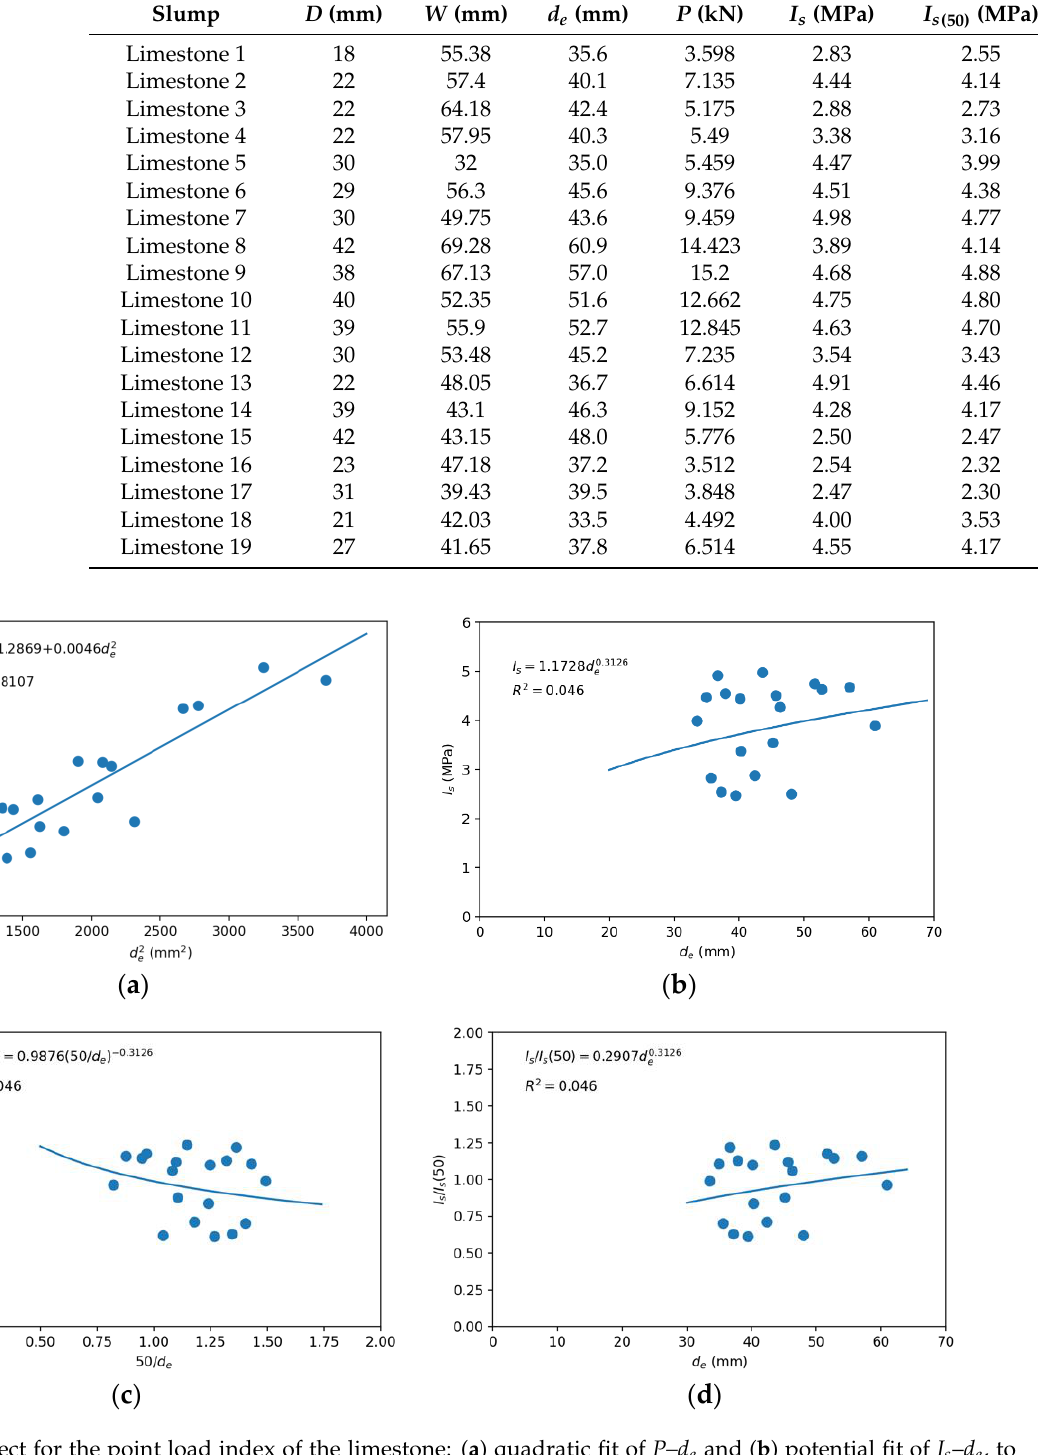
Table 5. Results of the point load test on limestone.